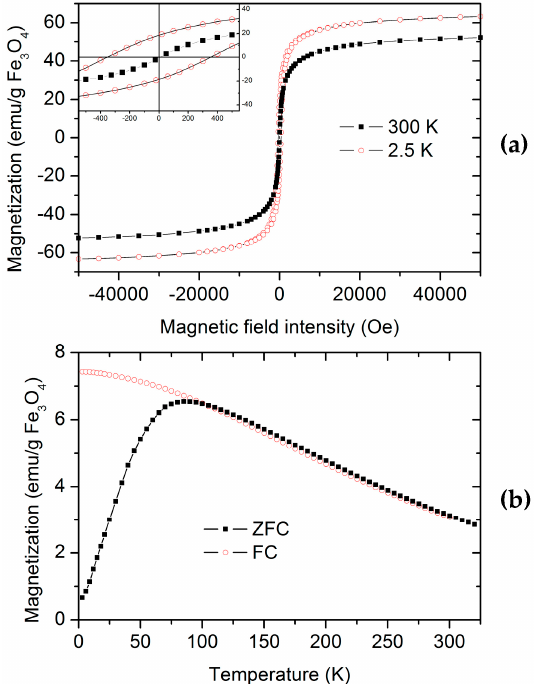
Figure 7. ( a ) Magnetization versus field intensity measured for the PNIPAM/CMC5/Fe 3 O 4 lyophilized hydrogel at 2.5 K and 300 K. In the inset the curves at low intensity magnetic field are shown; ( b ) zero field cooling (ZFC) and field cooling (FC) curves measured for the PNIPAM/CMC5/Fe 3 O 4 sample. These curves were measured with an applied field of 50 Oe.